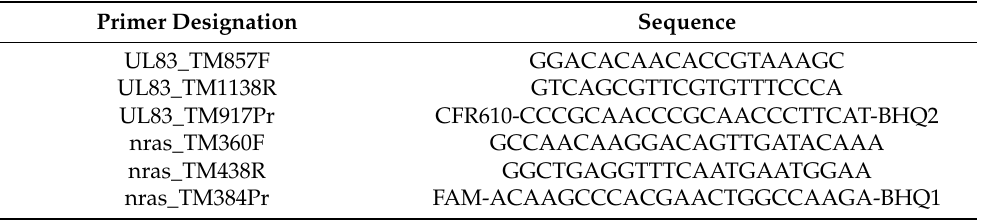
Table 1. Primer and probe sequences used for PCR detection of CMV genome (UL83